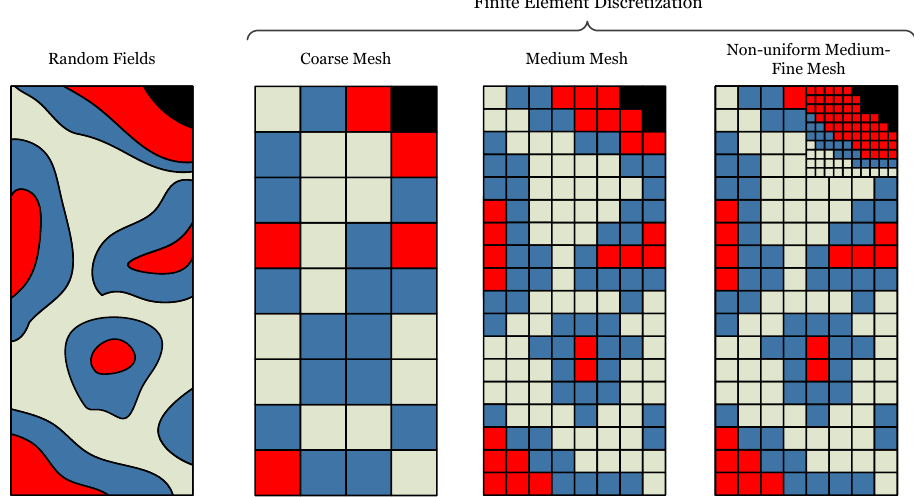
Figure 1. Sample random fields generation and its finite element